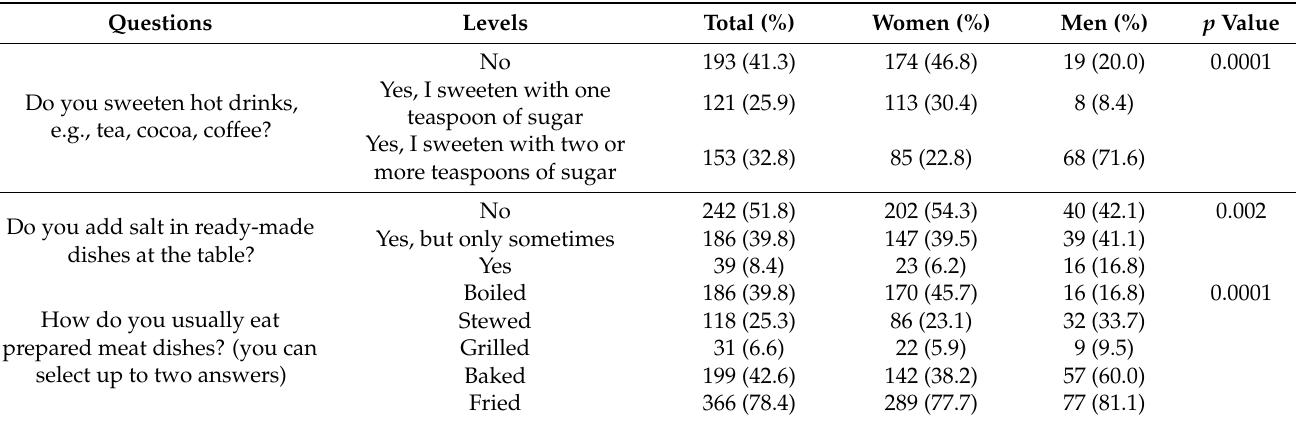
Table 6. Custom sweetening, salting and the preferred method of preparing meat dishes depending on the gender of young